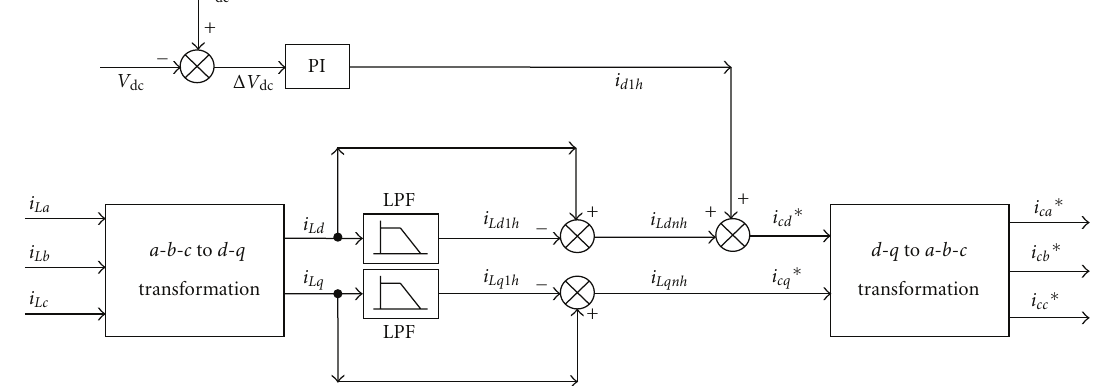
Figure 6: Reference compensation current extraction using i d - i q control scheme.